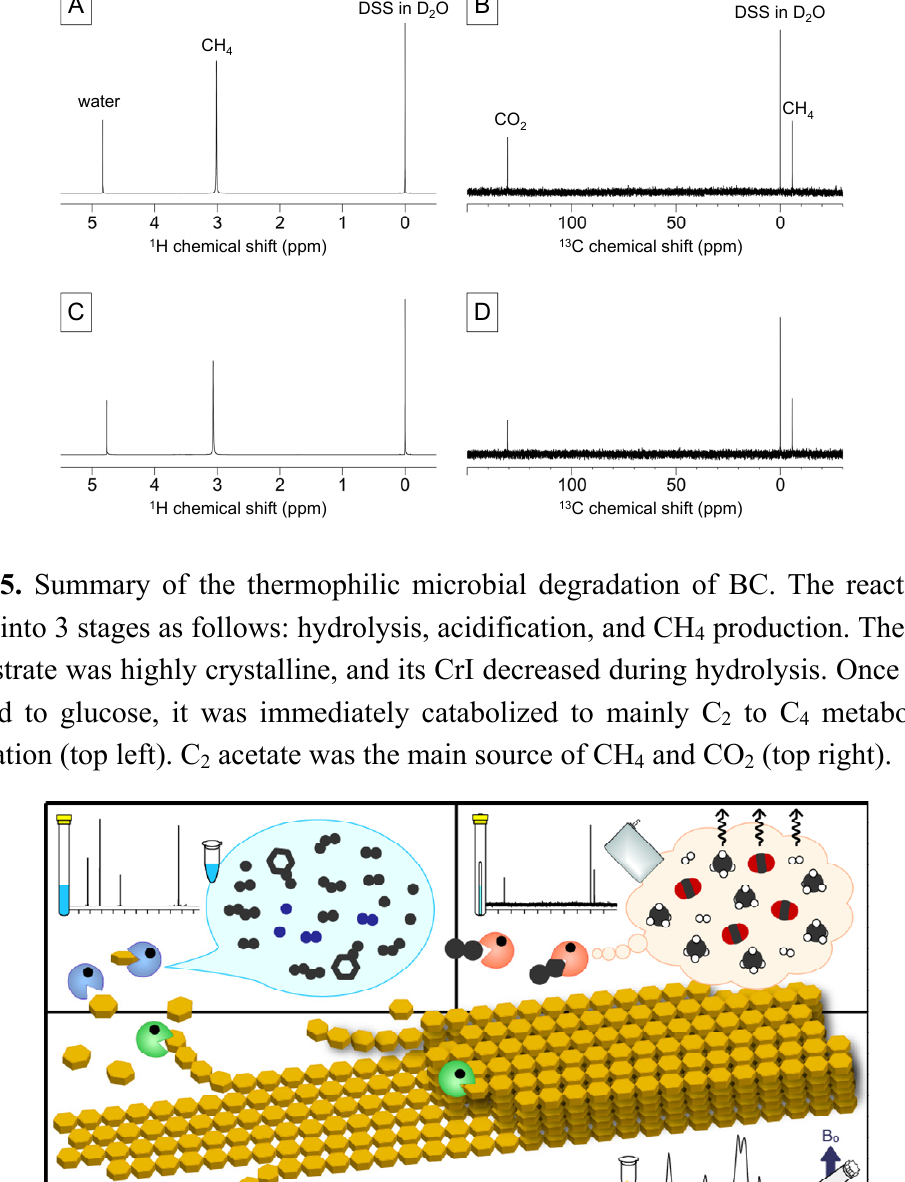
Figure 4. Gas-state 1 H- and 13 C-NMR spectra using a double-tube method. ( A ) 1 H- and ( B ) 13 C-NMR spectra of a mixture of standard gases (70% CH ( D ) 13 C-NMR spectra of biogas from the anaerobic digestion ecosystem.